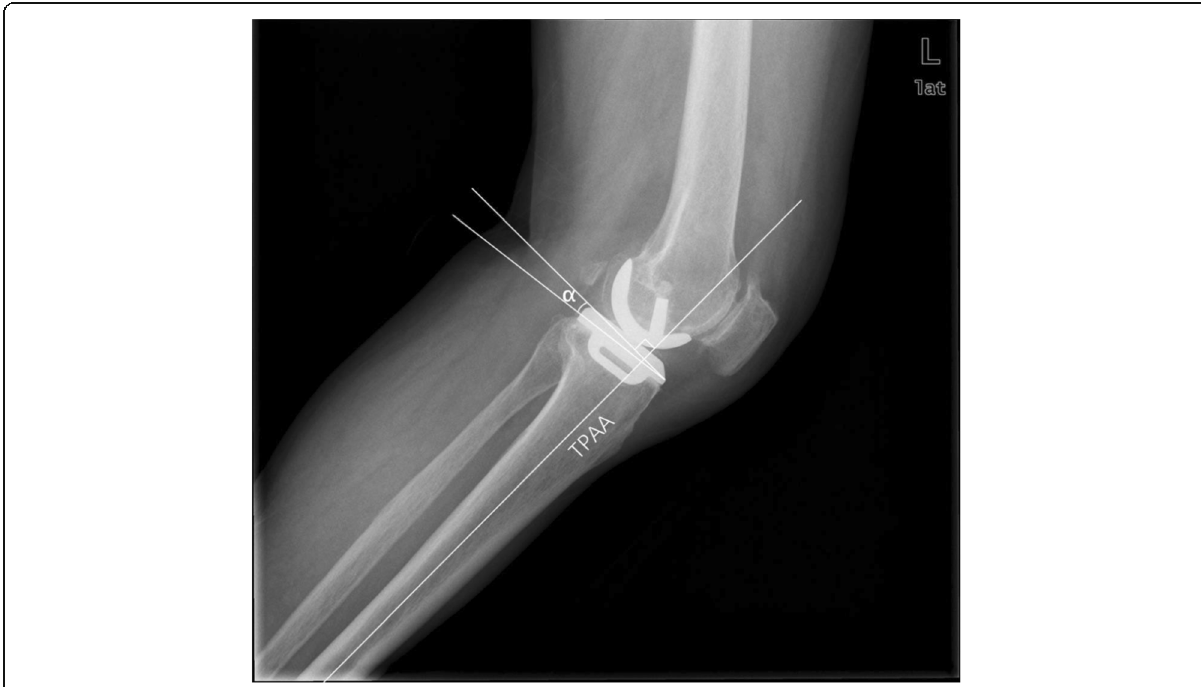
Fig. 2 The measurement method on standardized knee radiographs in the lateral view. TPAA, the tibial proximal anatomical axis. Tibial posterior slope (PTS) was defined by the angle between the posterior inclination line of the medial tibial plateau and a line perpendicular to the TPAA, which is defined by α -angle